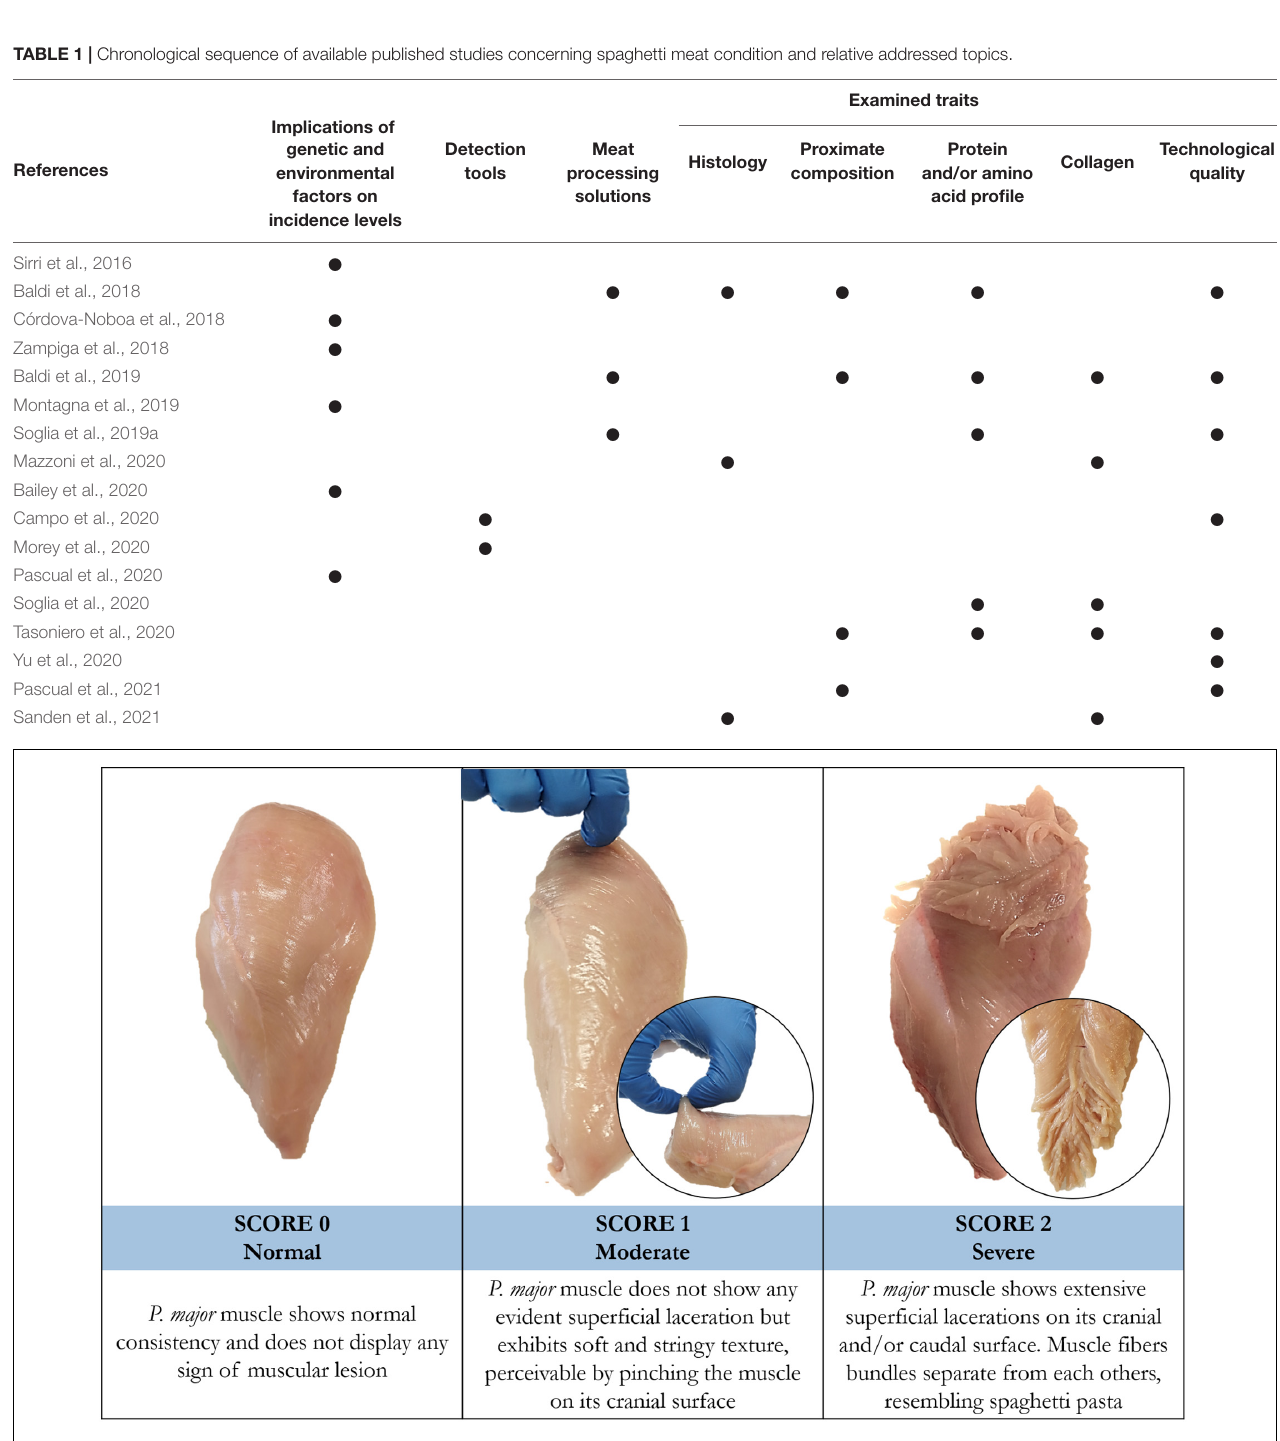
FIGURE 1 | Representative images of chicken breast fillets with normal (score 0), moderate (score 1) and severe (score 2) degrees of Spaghetti Meat.